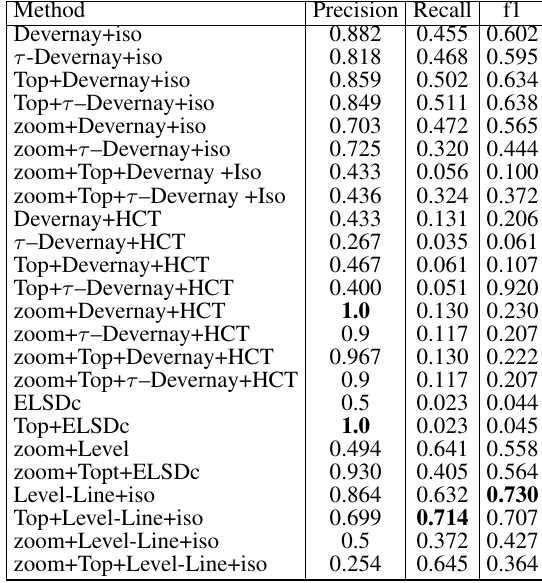
Table 2. Oil Tank detection performance. “iso”, “Top” and τ -Devernay respectively stands for the isoperimetric thresholding, Top-Hat and Otsu-Devernay methods The methods have been used with the set of parameters that maximizes the